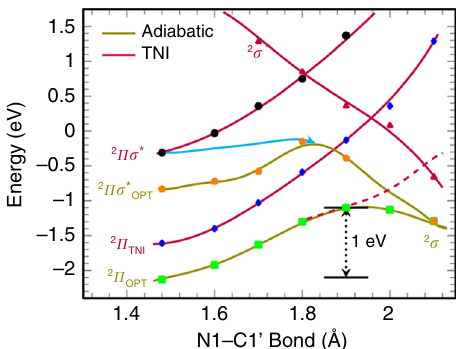
Fig. 5 Potential energy surface pro fi les for N1 – C1 ′ bond cleavage. Shown for the ground and vertical excited states of rT anions (TNI * ). The energies were scaled by adding − 1.6 eV to the actual calculated values (Supplementary Figure 8) to match with the theoretical adiabatic electron af fi nity (2.1 eV) of rT. The light blue solid line is the proposed path leading to barrierless fast N1 – C1 ′ bond dissociation